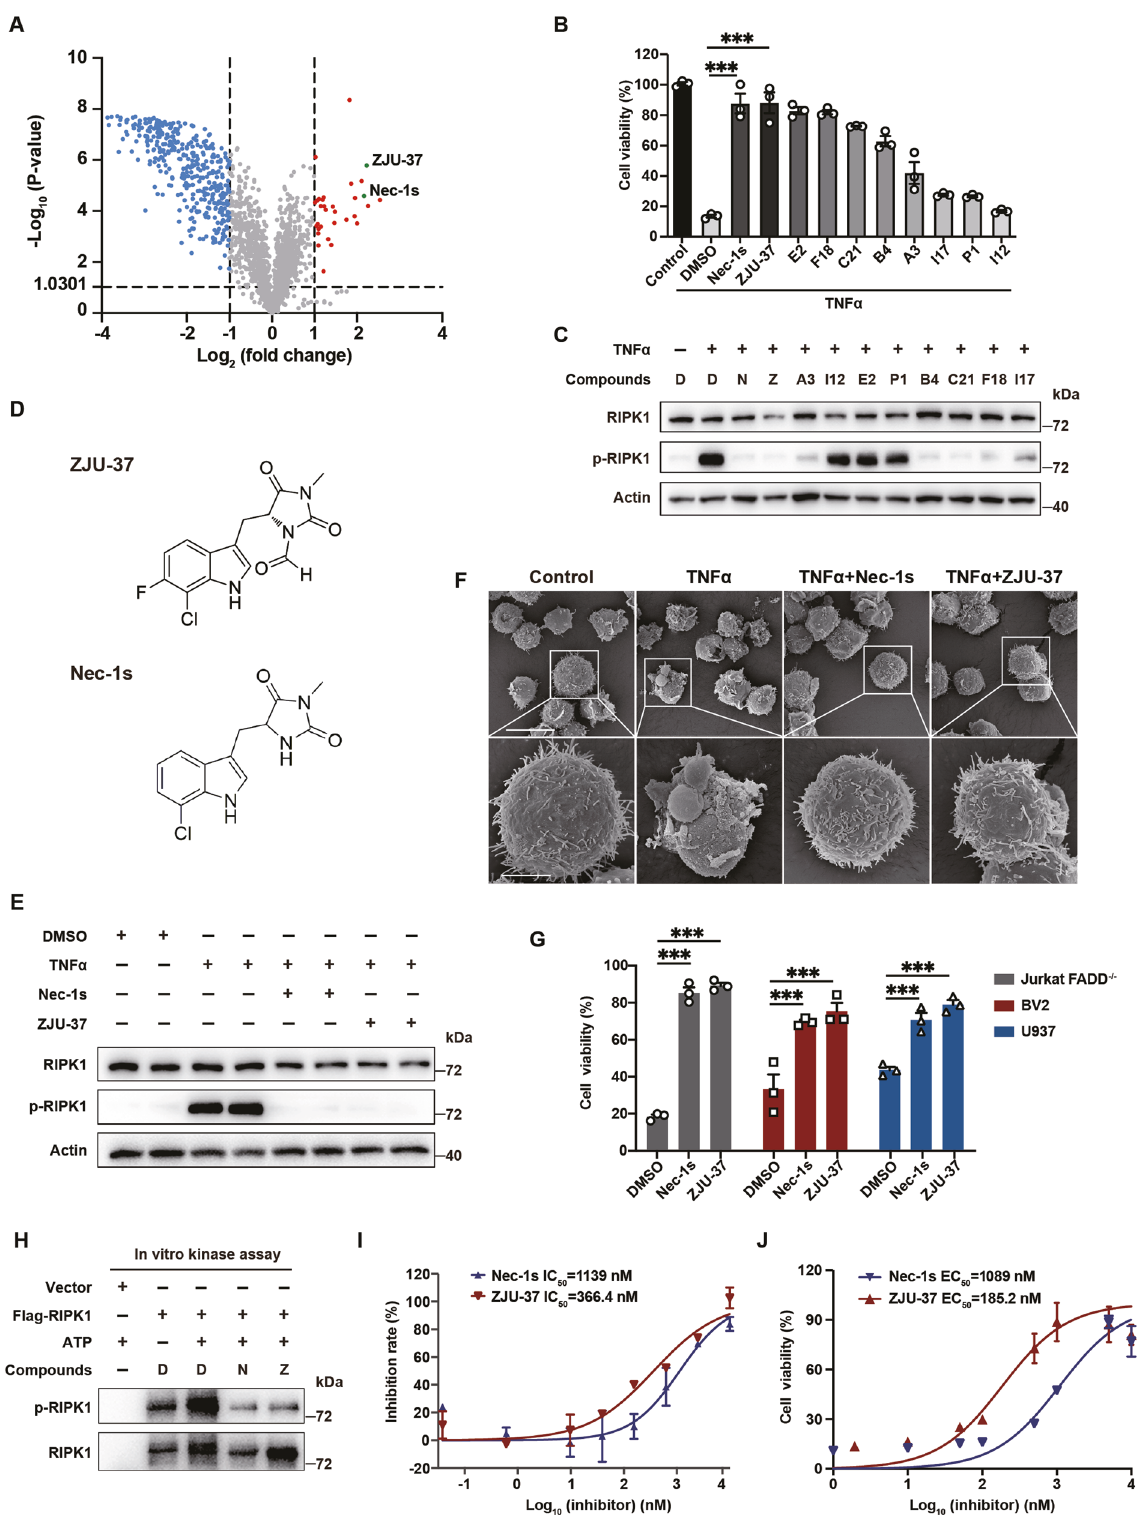
remyelinated axons (light blue) in ZJU-37 treatment group whereas more axons still remained demyelinated (pink) in the vehicle group (Fig. 5B). The frequency of remyelinated axon increased to 26% of total axons after ZJU-37 treatment (Fig. 5C). Unchanged G-Ratio value re fl ects no difference between